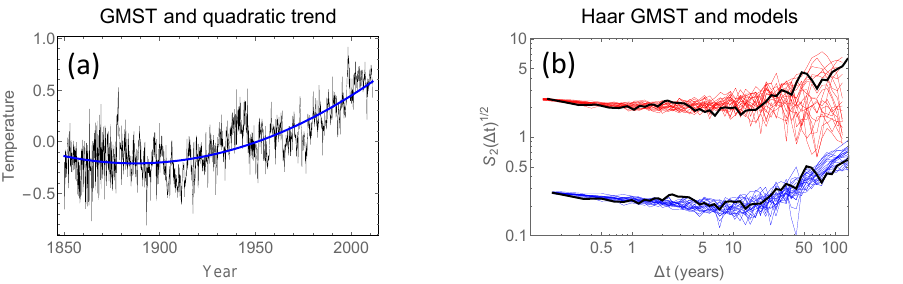
Figure 2. (a) The instrumental global mean surface temperature (GMST) 1850–2010 (black). A second-order polynomial least-squares fit to the GMST record (blue). (b) Black curves are the Haar fluctuation function of the GMST; the upper curve is multiplied by 10. The red curves are Haar fluctuation functions of 20 realizations of a model comprised of a linear combination of an fGn with β = 0.8 and an fBm with β = 1.6. The blue curves are the same but of a model comprised of a linear combination of an fGn with β = 0.8 and the second-order polynomial